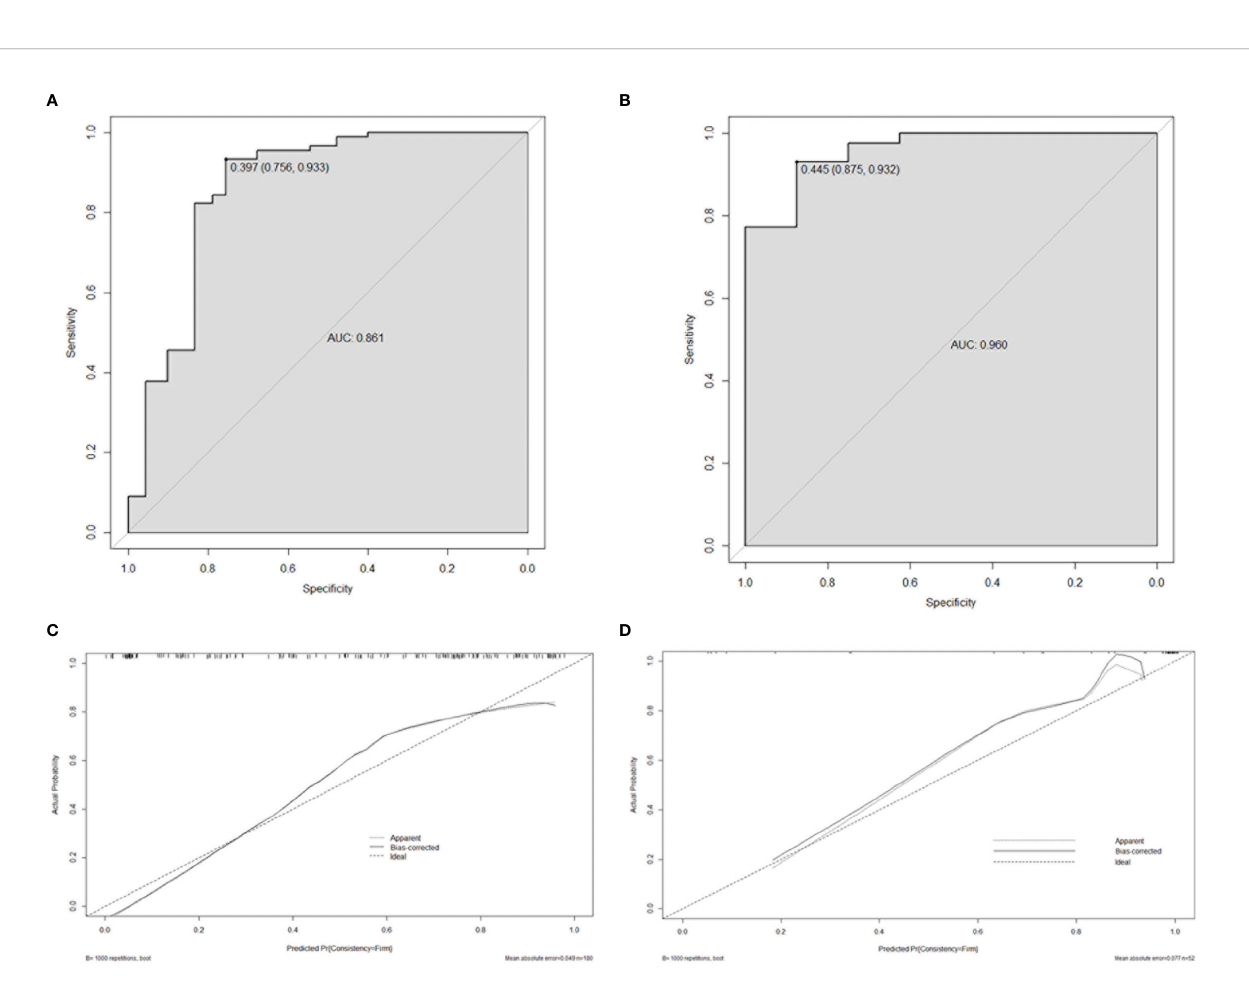
FIGURE 4 | The performance evaluation of the radiomics nomogram. (A) the ROC curve in train cohort; (B) the ROC curve in test cohort; (C) the calibration curve in train cohort; (D) the calibration curve in test cohort.